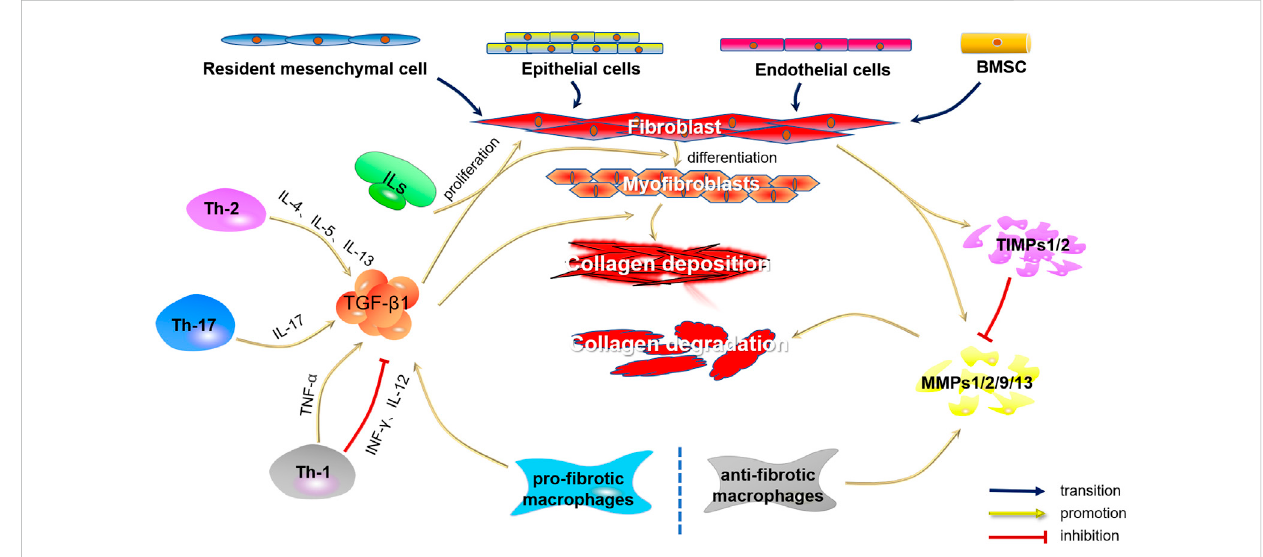
FIGURE 1 Cells and cytokines involved in fi